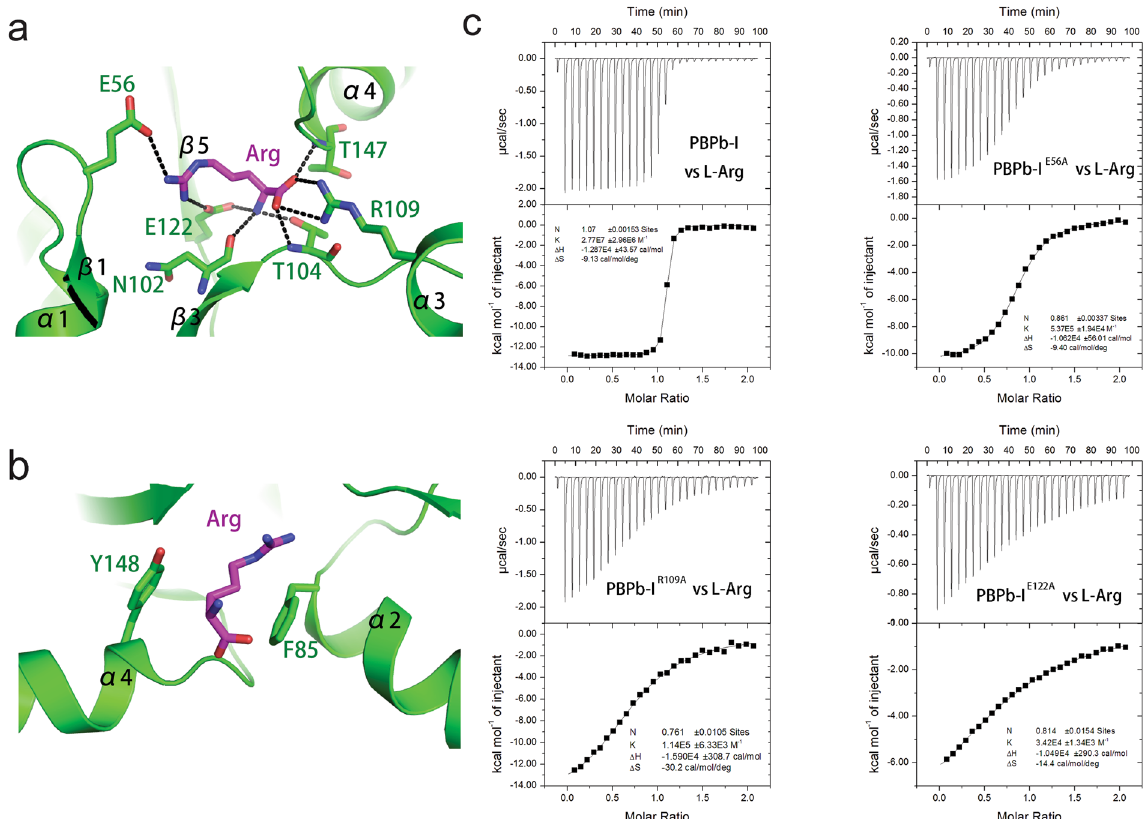
Figure 2. Structural details of the ligand-binding pocket in the PBPb-I domain. ( a ) Hydrophilic interactions. ( b ) Hydrophobic interactions. The PBPb-I domain is shown as a green cartoon, and the residues involved in ligand-binding interactions are shown as green sticks. L-arginine is shown in magenta. ( c ) Data from ITC experiments involving the PBPb-I domain (the refolded PBPb-I or PBPb-I mutants, as indicated) in complex with